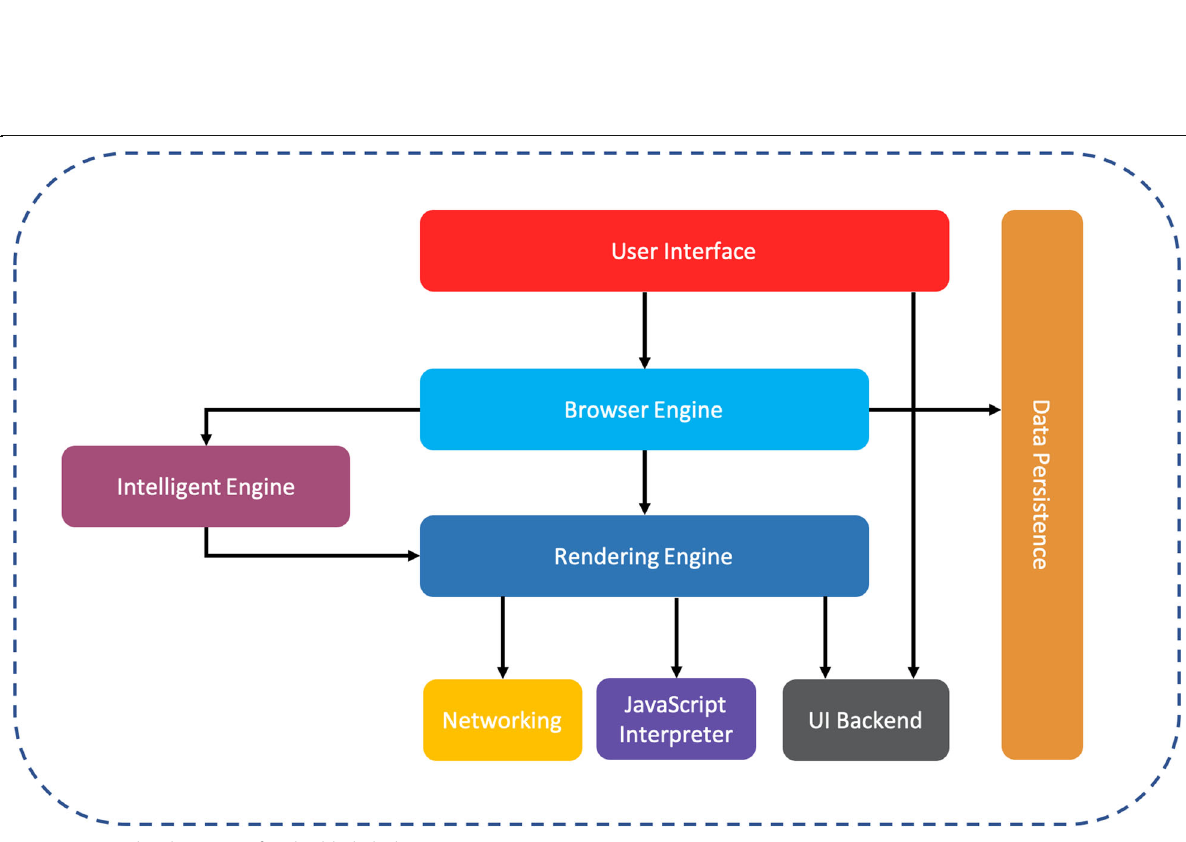
Fig. 3 Proposed architecture of Embedded Phishing Detection Browser